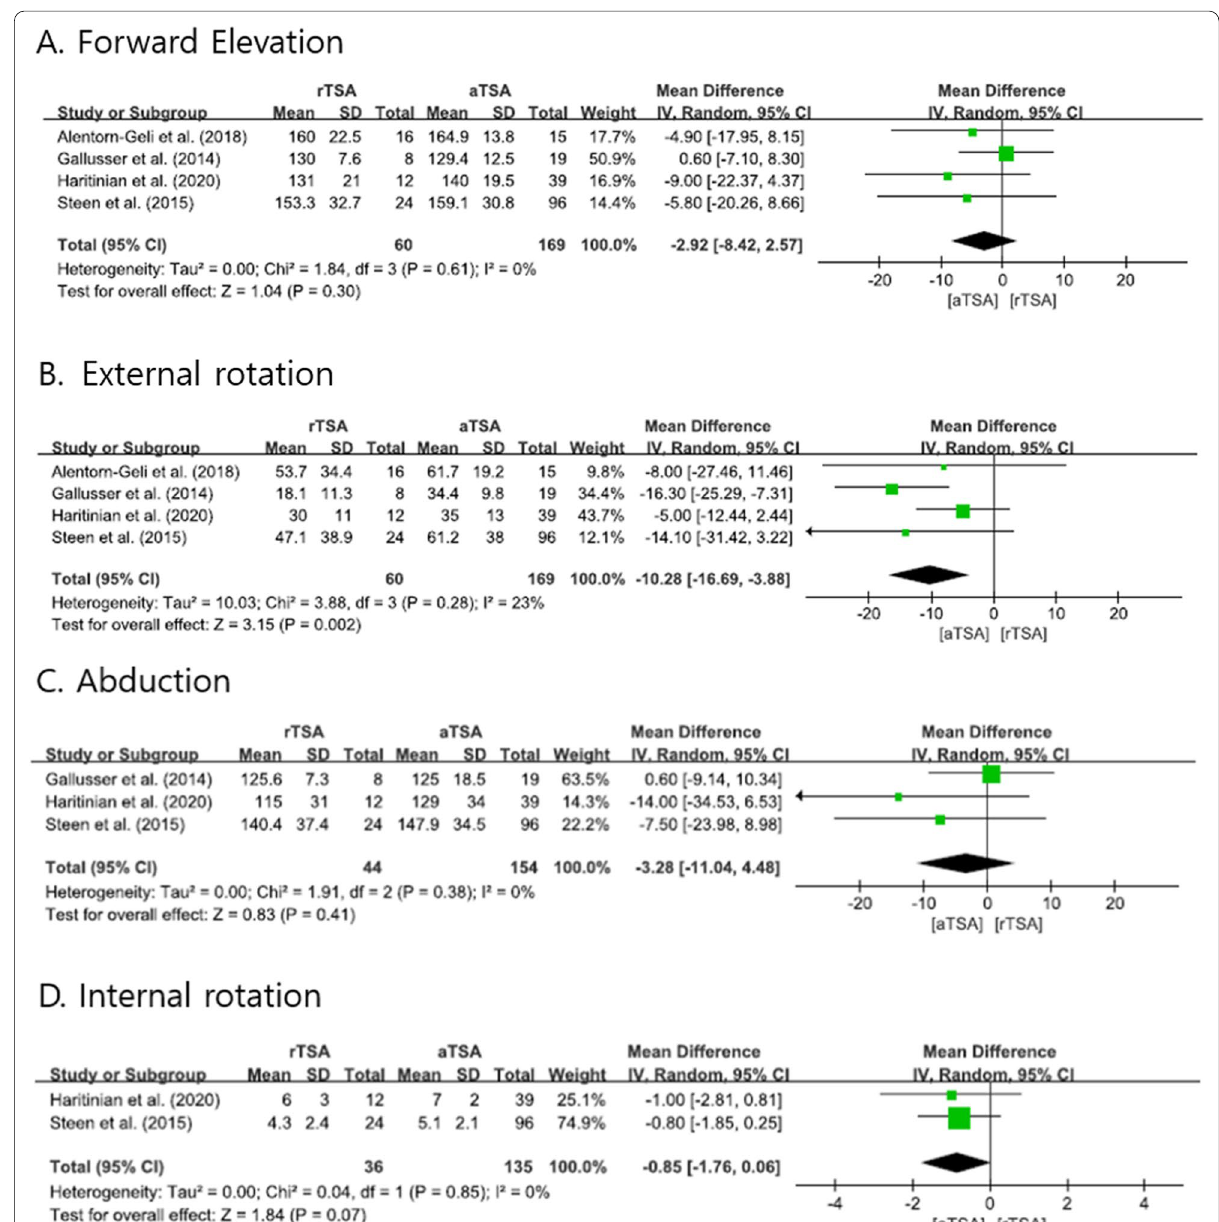
Fig. 2 Forest plots showing the differences in range of motion between reverse total shoulder arthroplasty and anatomical total shoulder